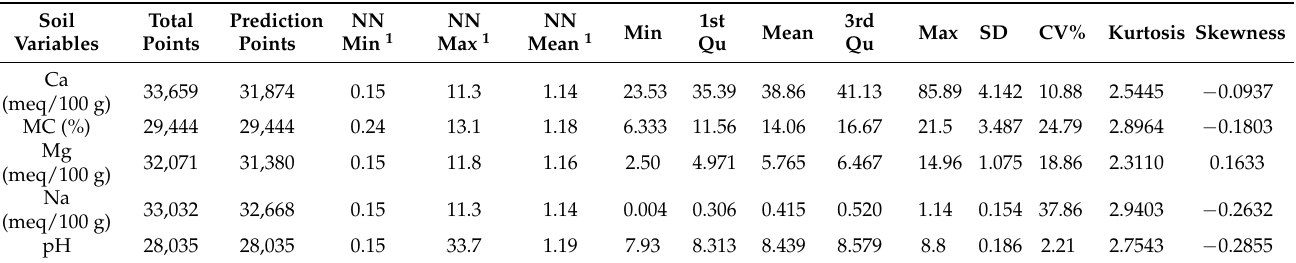
Table 1. Statistical summary of soil variables estimated from VNIR spectrometer data from soil scanner with nearest neighbor and attribute